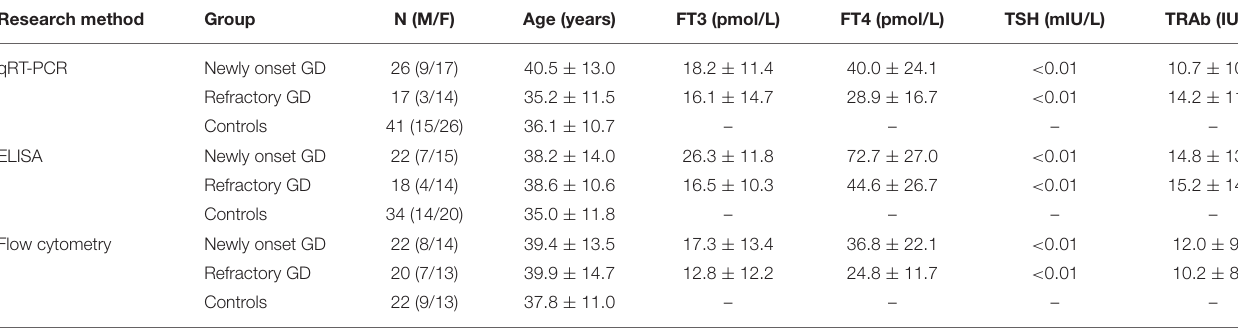
TABLE 1 | Clinical data of all subjects. Research method Group